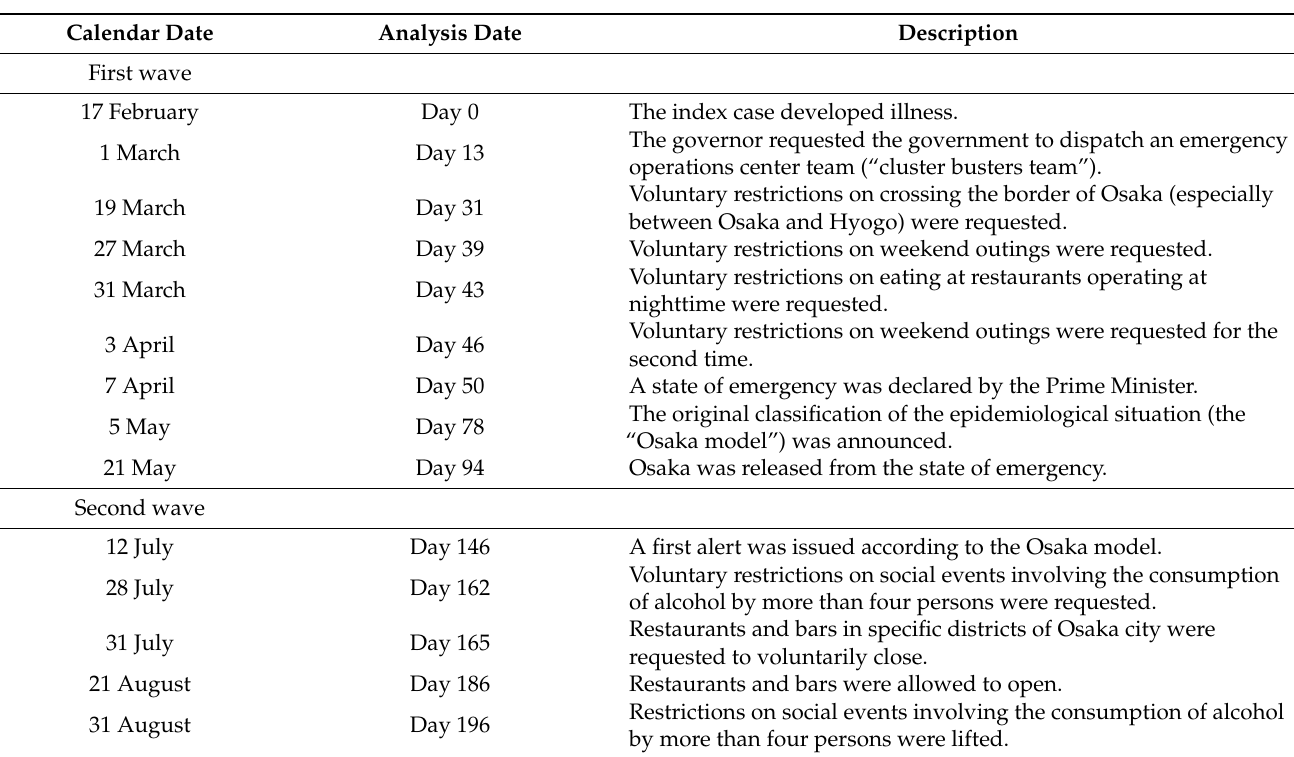
Table 1. Chronology of the coronavirus disease 2019 (COVID-19) epidemic in